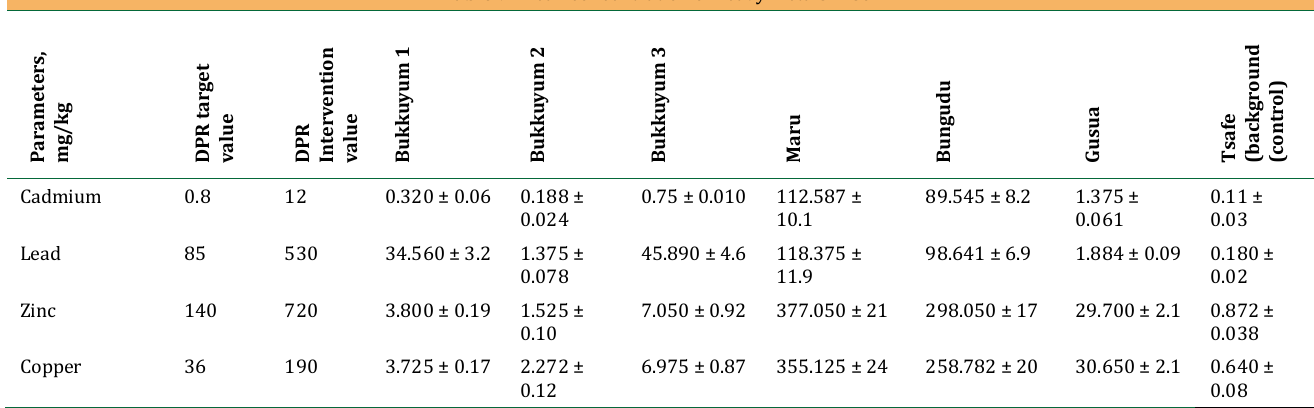
Table 9: Mean concentration of heavy metals in soil